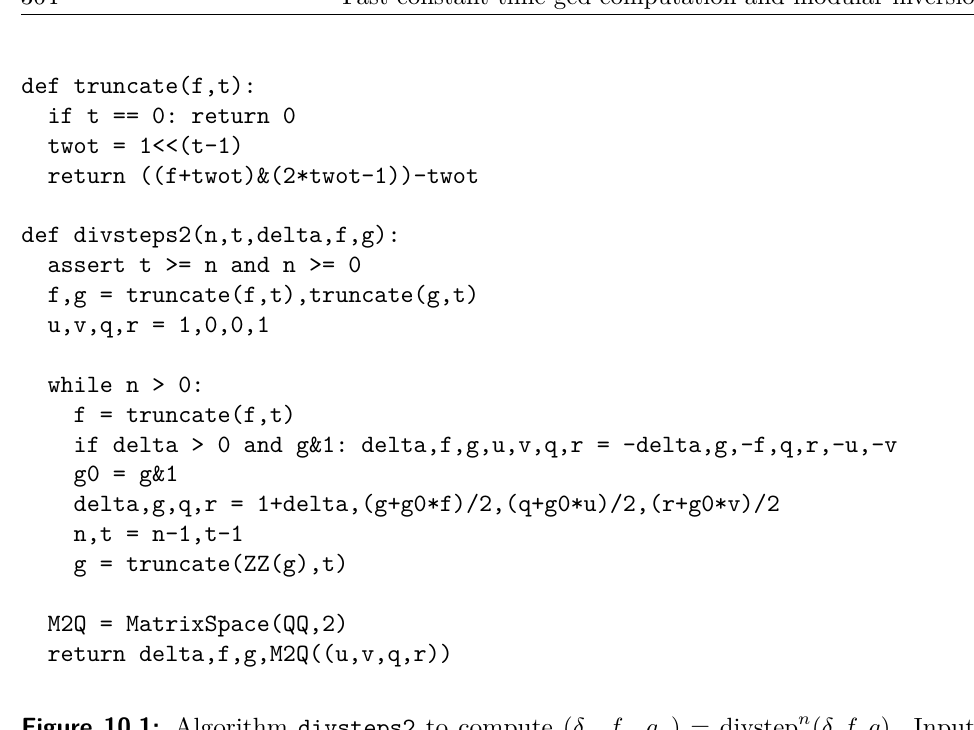
Figure 10.1: Algorithm divsteps2 to compute ( δ n , f n , g n ) = divstep n ( δ, f, g ). Inputs: n, t ∈ Z with 0 ≤ n ≤ t ; δ ∈ Z ; at least bottom t bits of f, g ∈ Z 2 . Outputs: δ n ; bottom t bits of f n if n = 0, or t − ( n − 1) bits if n ≥ 1; bottom t − n bits of g n ; T n − 1 · · · T 0